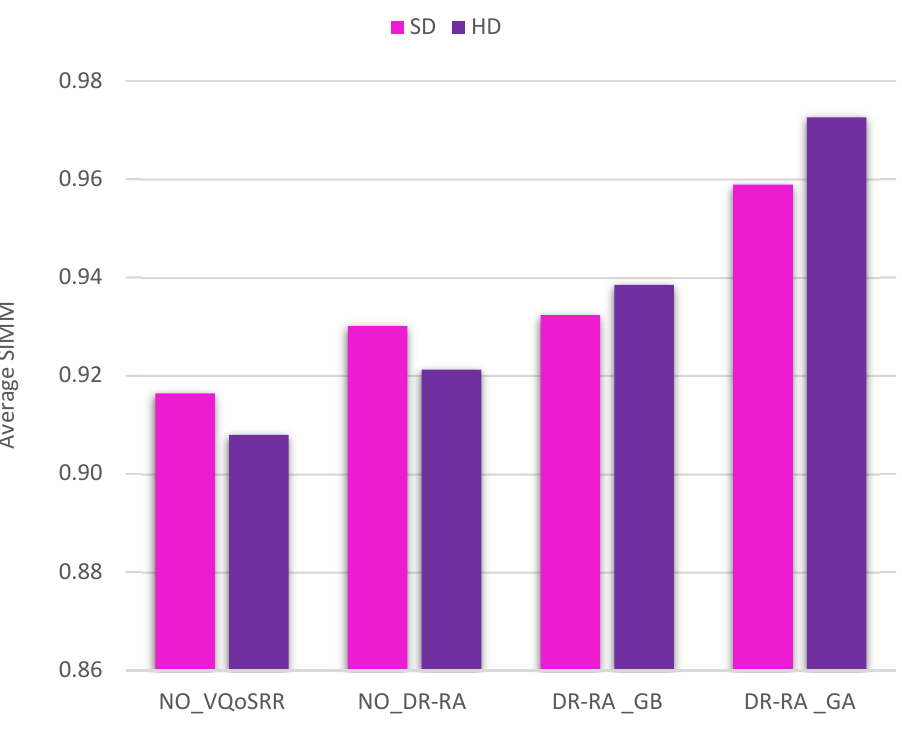
Figure 6. Average SSIM of the four testing scenarios.